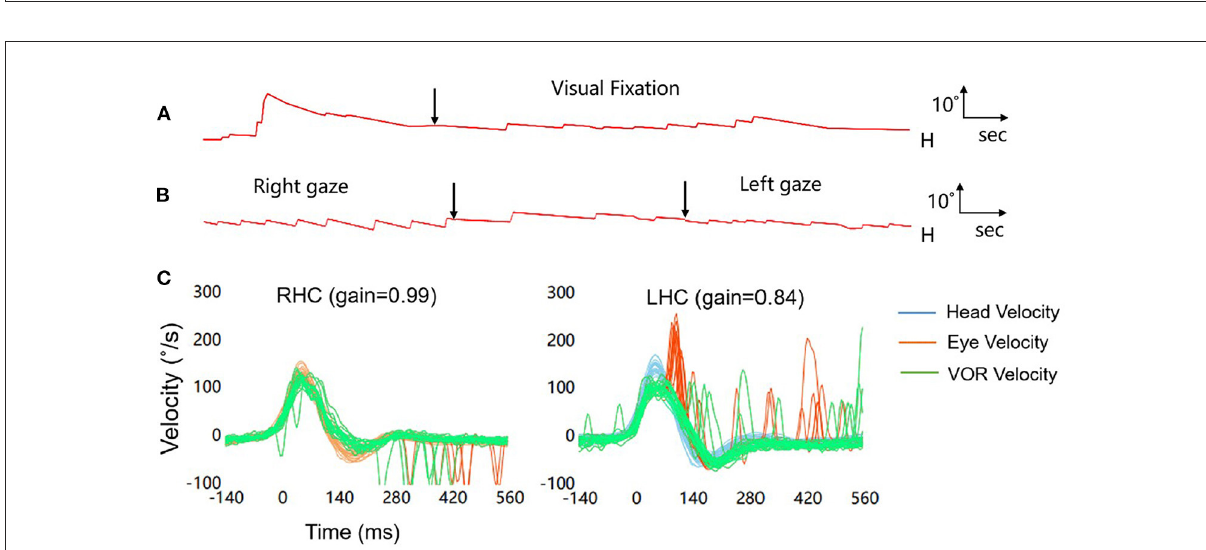
FIGURE3 (A) Without visual fixation, the patient demonstrates spontaneous right-beating nystagmus with a linear nystagmus waveform and a mean slow-phase velocity (SPV) of 7.7 ◦ /s, which decreases during visual fixation, with a mean SPV of 1.6 ◦ /s. (B) Nystagmus in all gaze directions is similar with spontaneous nystagmus, and is more intense upon staring to the right. (C) Results of the video-oculography-based HIT (vHIT) (RHC, right horizontal semicircular canal; LHC, left horizontal semicircular canal). The vHIT results demonstrate numerous corrective saccades in the left horizontal semicircular canal, but the VOR gain is in the normal range, thereby suggesting damage in the central nervous system. vHIT examination of the bilateral anterior semicircular canal and posterior semicircular canal reveals no